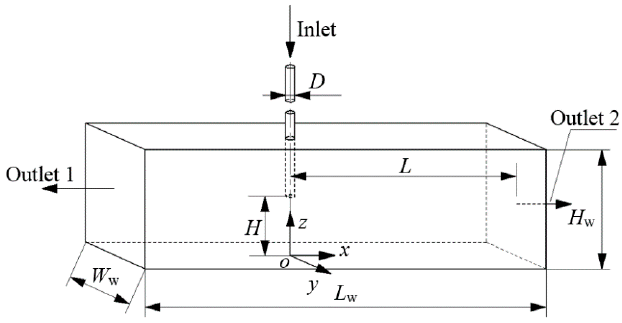
Figure 1. Three-dimensional submerged vertical jet. Table 1. Computational conditions of submerged impinging jet.